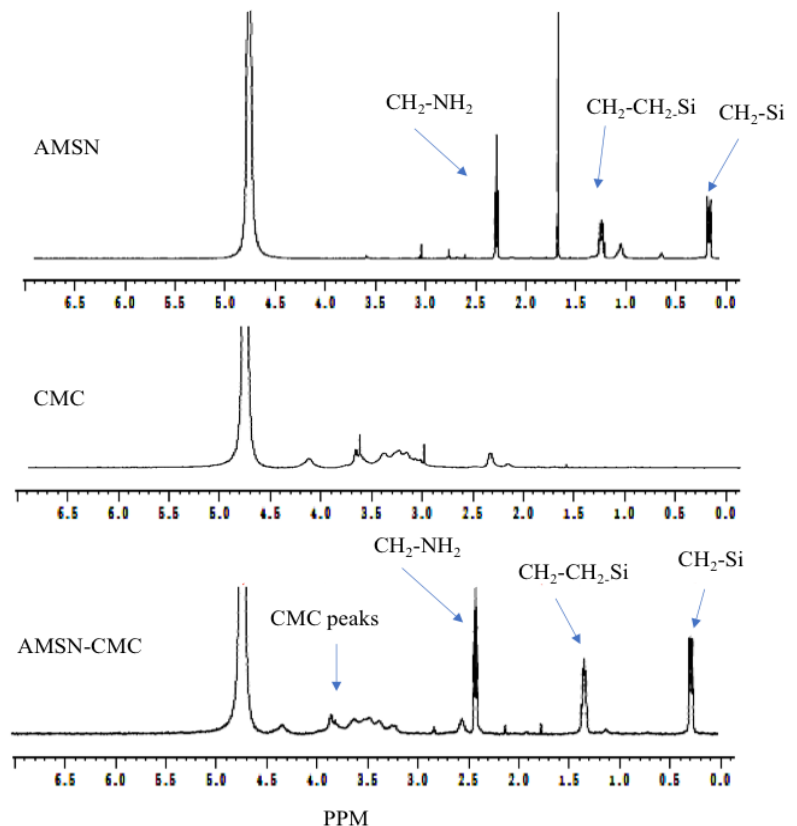
Figure 2. Proton NMR spectra of AMSN, CMC, and AMSN-CMC.